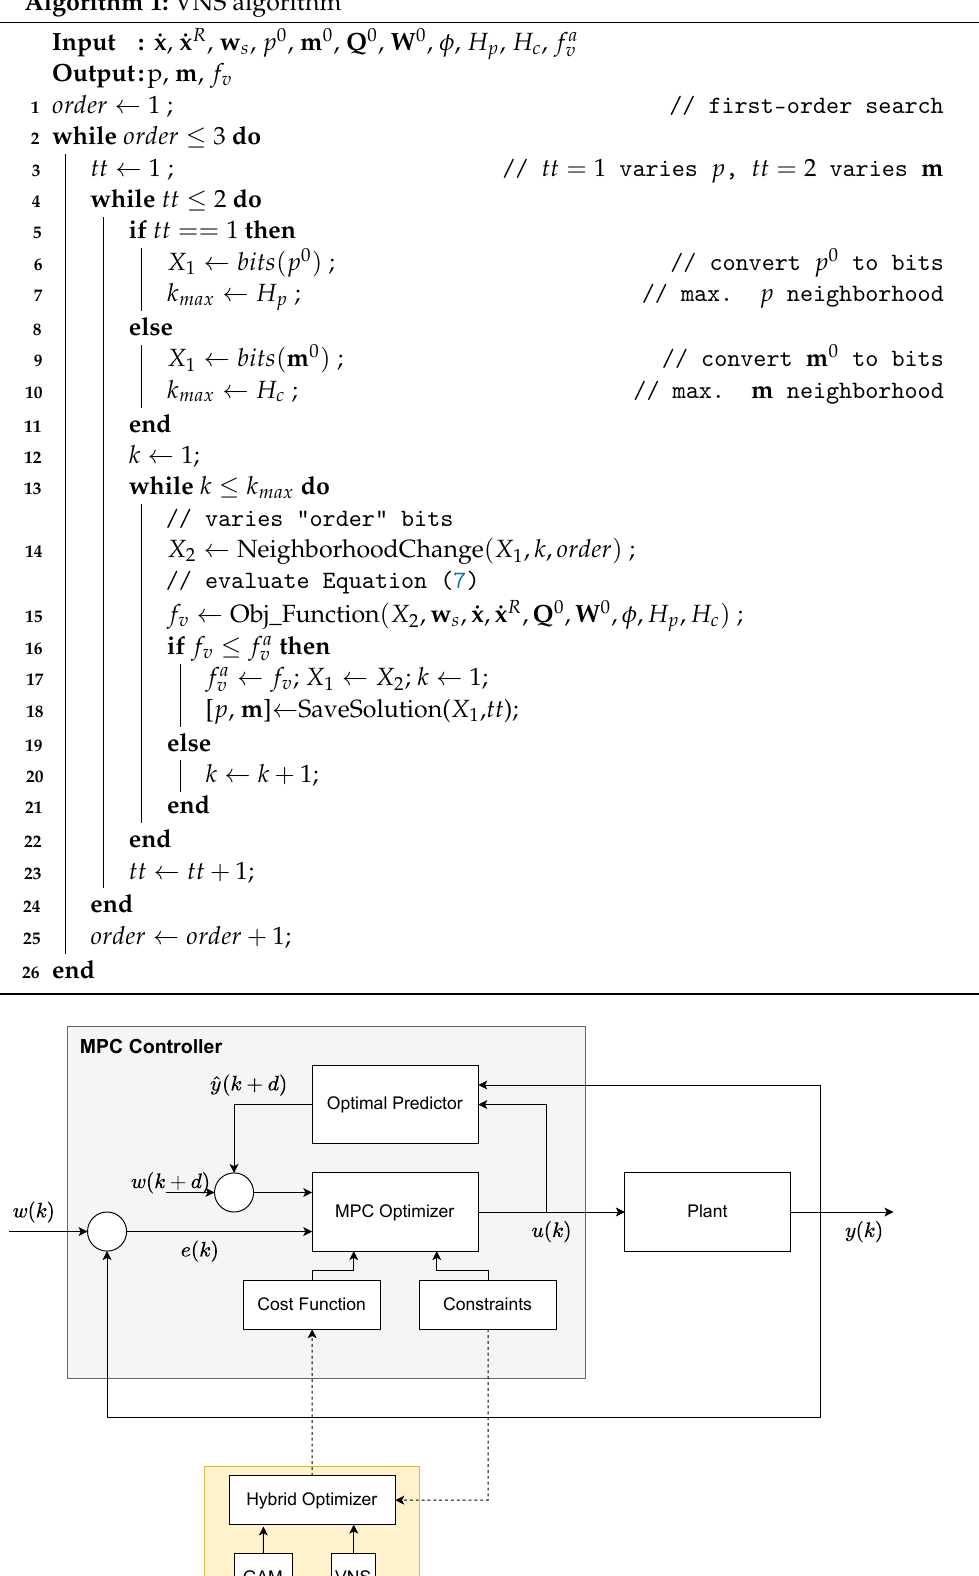
Algorithm 1: VNS algorithm